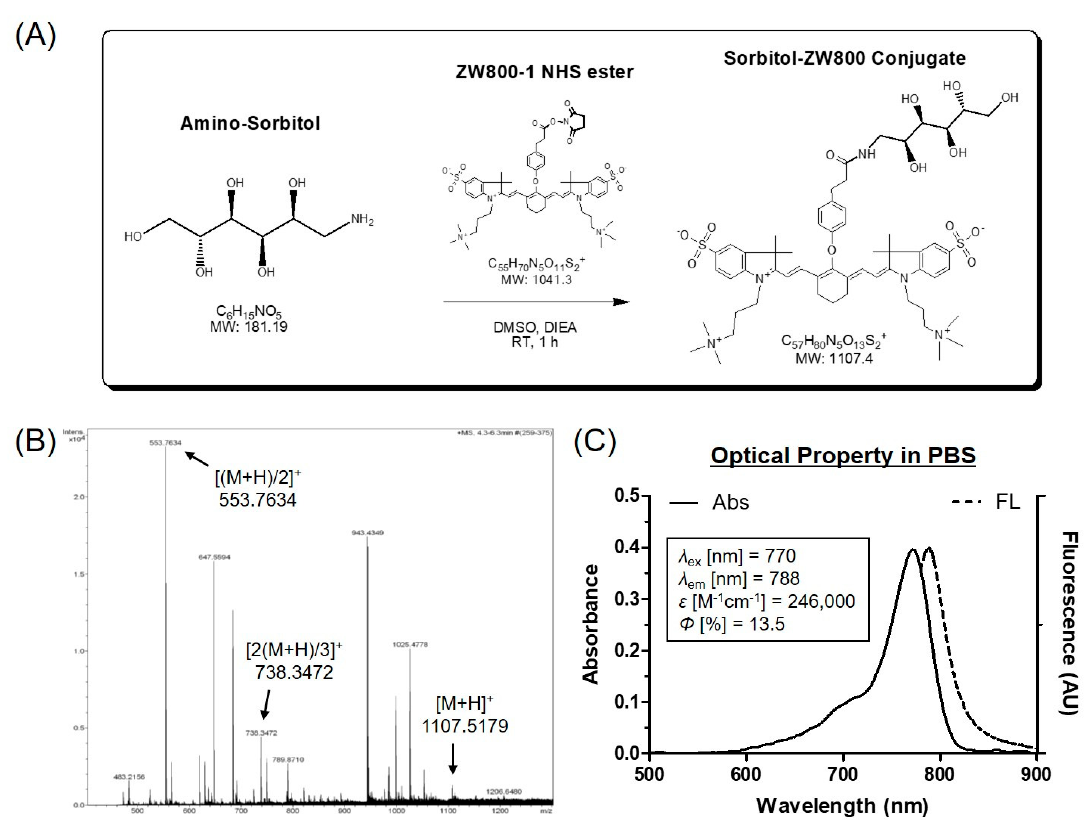
Figure 1. ( A ) Synthetic scheme, ( B ) mass spectrum, and ( C ) optical property of sorbitol–ZW800 conjugate. All optical measurements were performed in PBS, pH 7.4. conjugate. All optical measurements were performed in PBS, pH